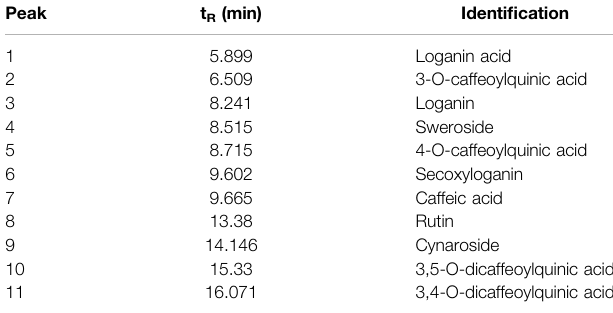
TABLE 3 | Chemical components identi fi ed from C . lonicerae by HPLC-ESI/MS n . Peak t R